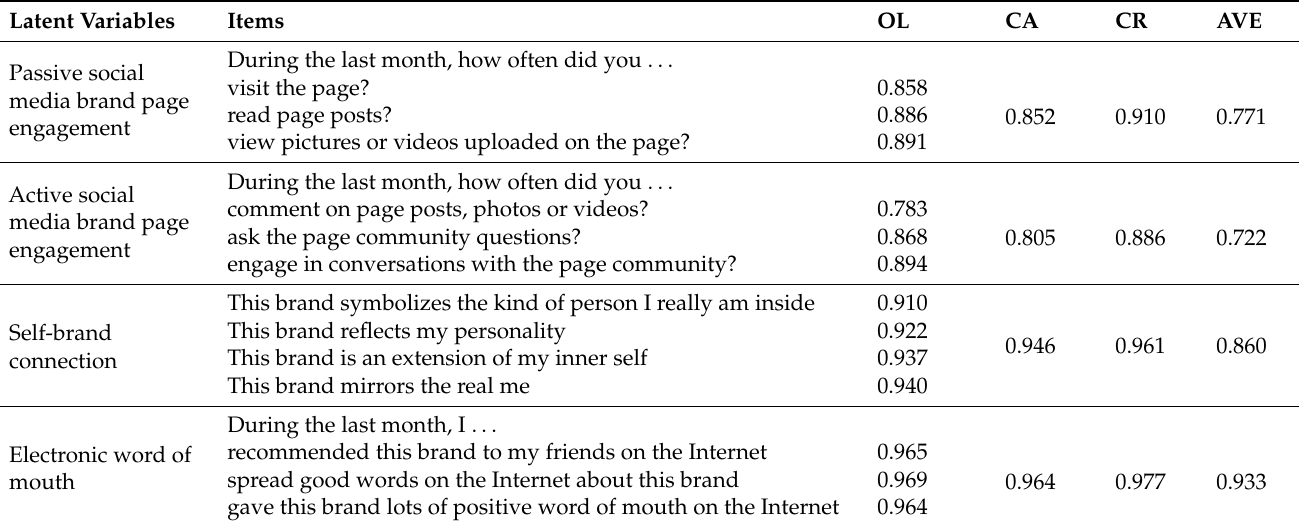
Table 1. Internal consistency and convergent validity assessment.